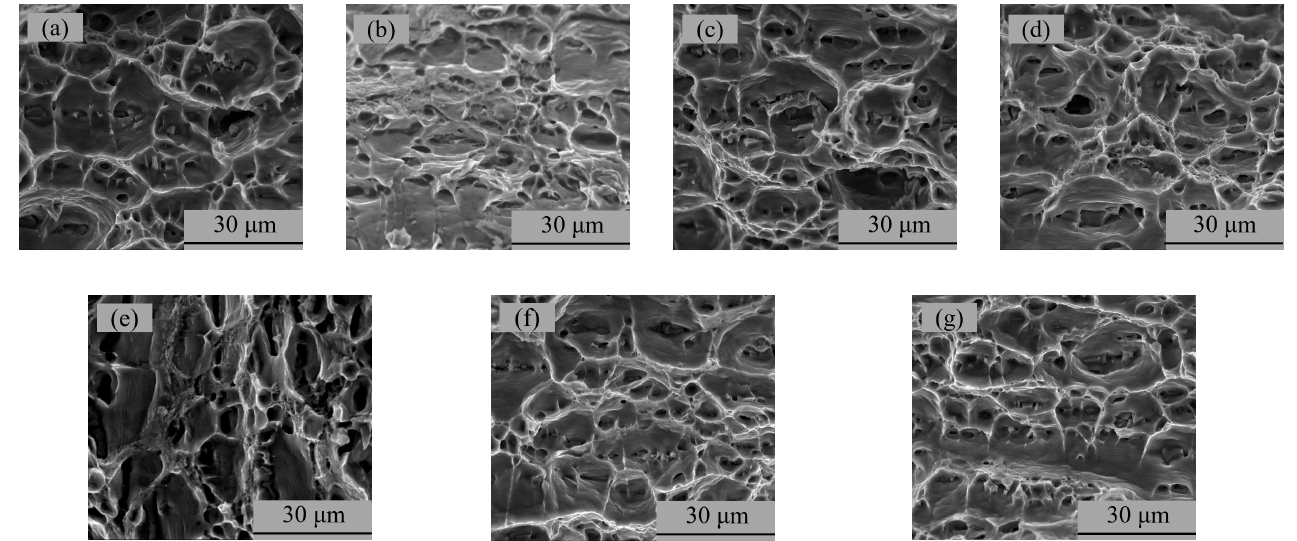
Figure 9. SEM photographs of the fracture surface: ( a ) specimen A01; ( b ) specimen A02; ( c ) specimen A03; ( d ) specimen A04; ( e ) specimen A05; ( f ) specimen A06; ( g ) specimen A07.